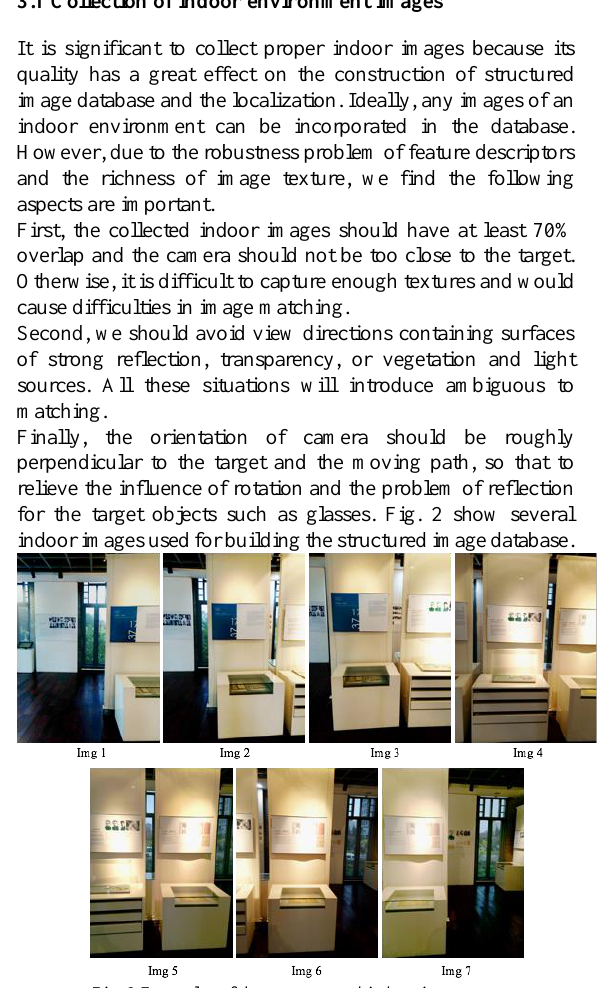
Fig. 2 Examples of the pre-captured indoor image sets